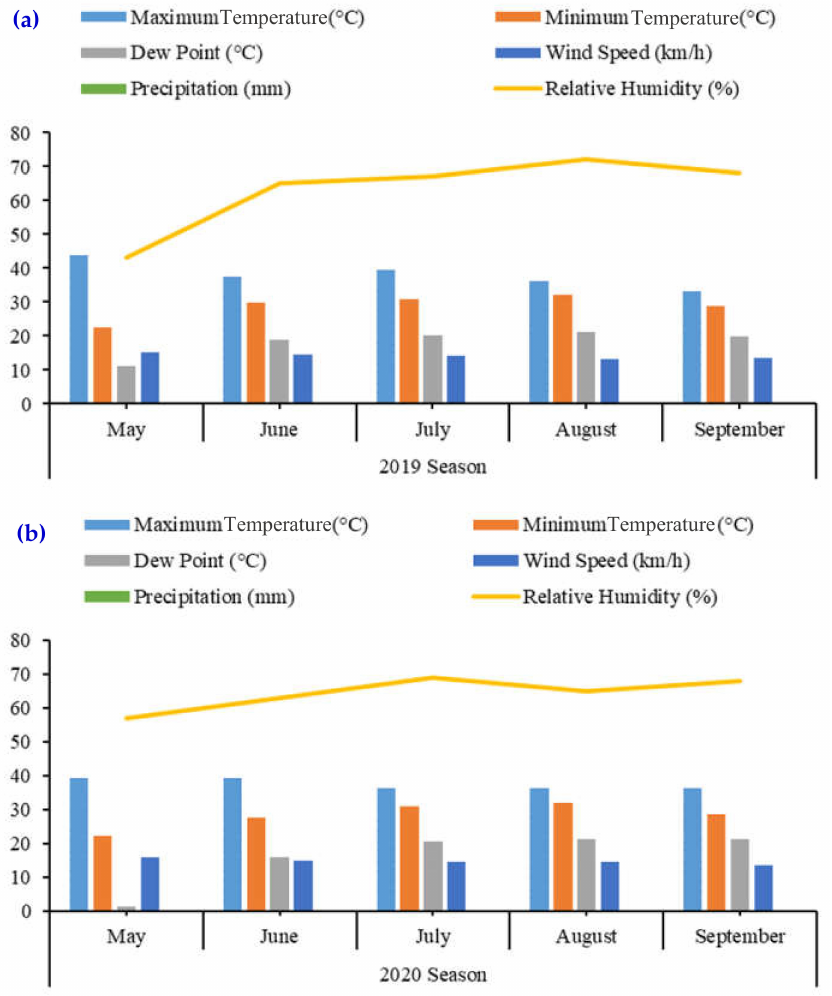
Figure 1. Monthly weather data for the experiment field during both growing summer seasons. (2019 ( a ) and 2020 ( b